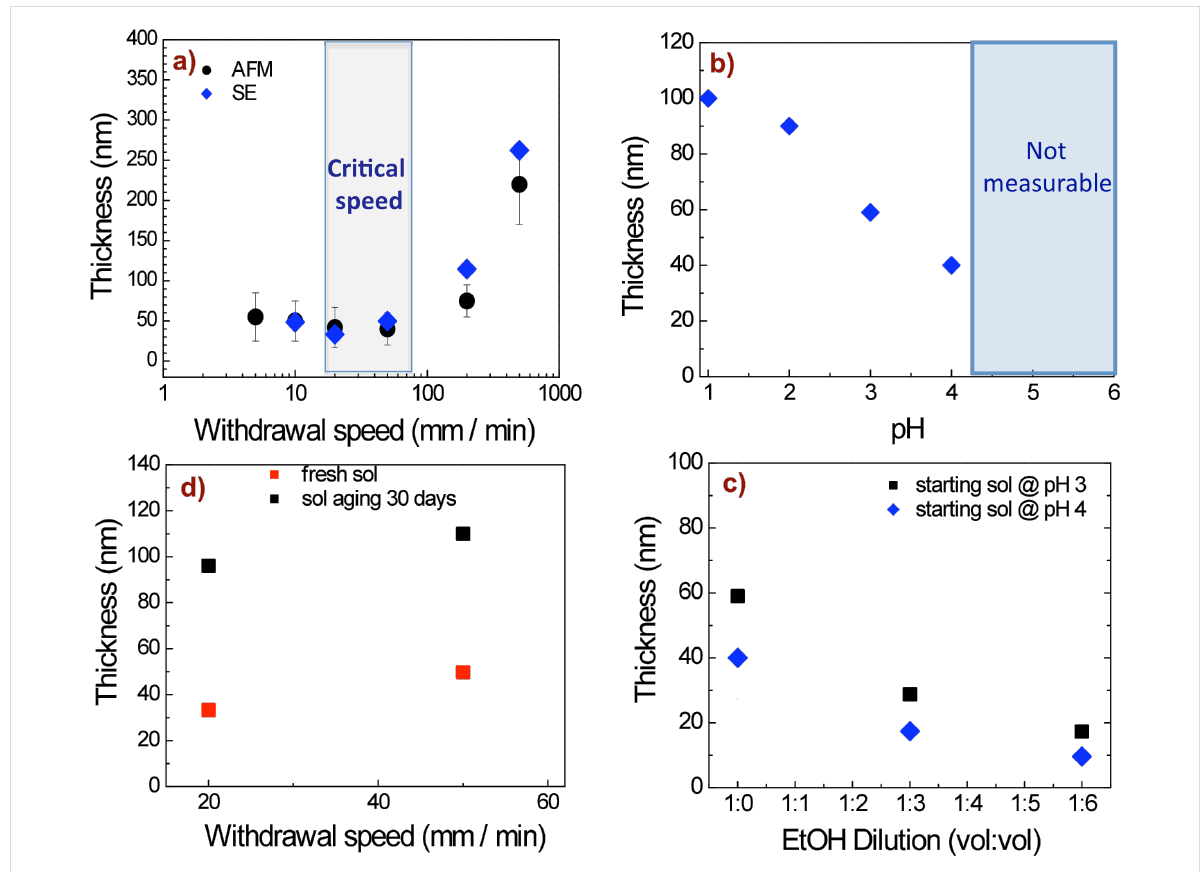
Figure 1: (a) Film thickness as a function of withdrawal speed for a sol of pH ≈ 4 and few days of aging, comparing results from both AFM and SE measurements. (b) Plot of the thickness versus starting pH value obtained at a withdrawal speed of 50 mm/min. (c) Plot of the thickness versus EtOH dilution at a withdrawal speed of 50 mm/min. (d) Plot of the thickness of a film prepared from fresh sol (starting pH ≈ 4) and from sol after 30 days.